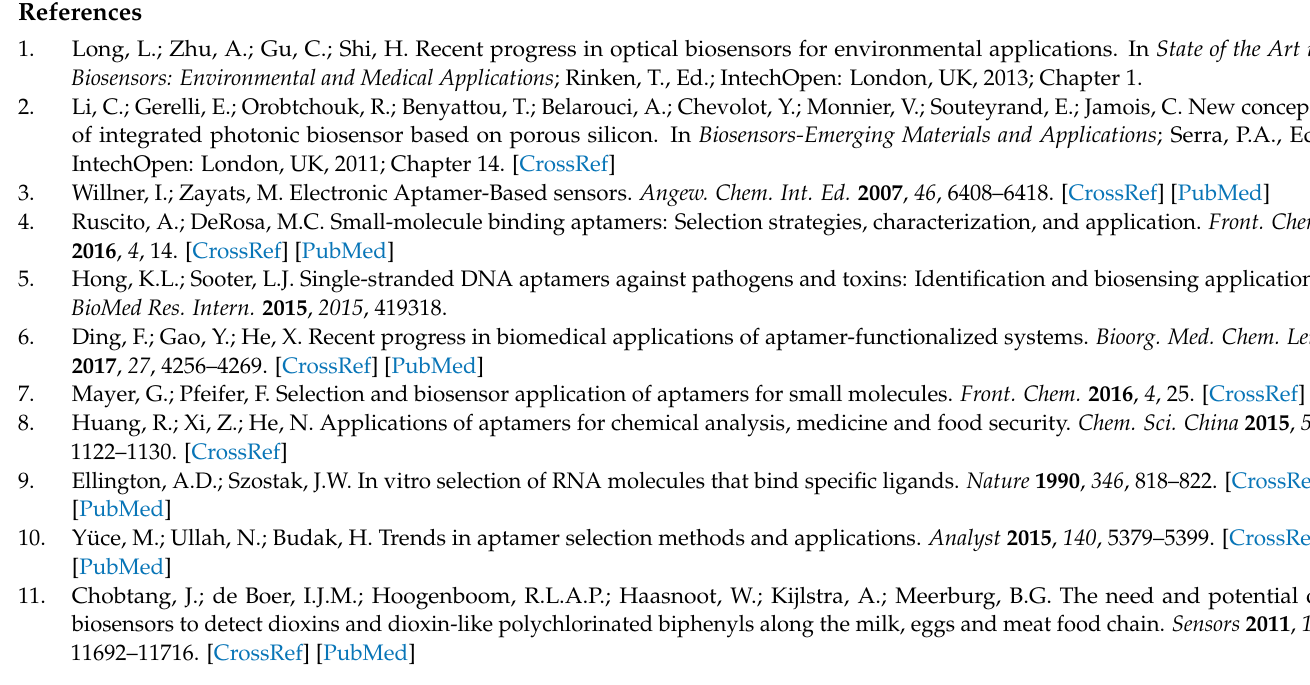
Figure S2: The UV spectrum (275–350 nm), in DMF, of amino-substituted dioxin 17 before (green line) and after (red line) coupling with the carboxy-substituted magnetic beads, Figure S3: The ATR-FTIR spectrum of amino-substituted dioxin 17 , Figure S4: The ATR-FTIR spectrum of magnetic beads, Figure S5: The ATR-FTIR spectrum of magnetic beads coated with the amino-substituted dioxin 17 , Figure S6: The ATR-FTIR spectrum of magnetic beads coated with